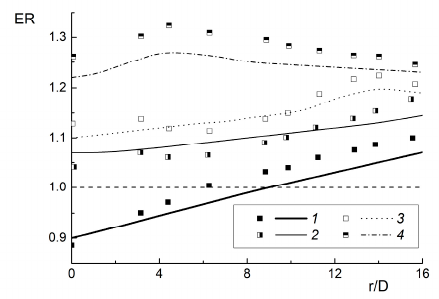
Figure 12. Heat transfer enhancement ratios along the radial distance for rectangular type of unsteadiness. Points are the measurements results of [16], lines are authors’ predictions. Re = 7500, D = 15 mm, H / D = 3, q W = 420 W/m 2 , St = (0.2–8) × 10 − 2 . 1 — f = 1.25 Hz, 2 —5 Hz, 3 —10 Hz, 4 —40 Hz.